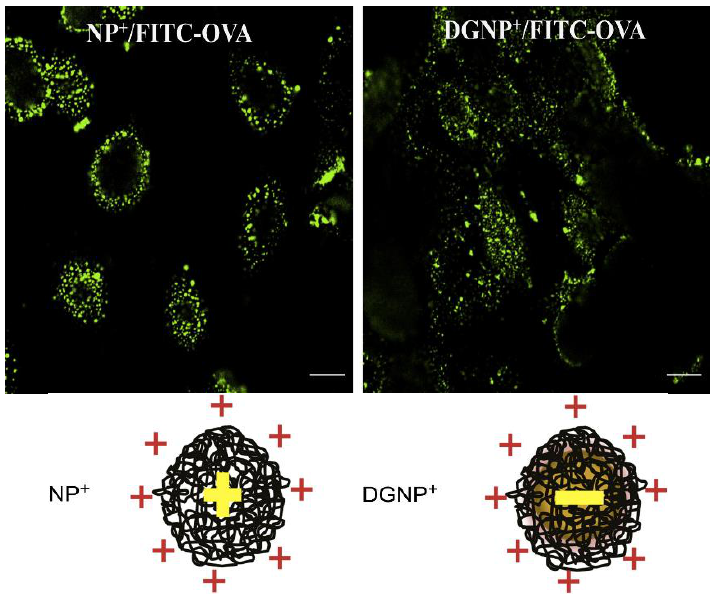
Figure 15. Comparison of ovalbumin (OVA) intracellular delivery by maltodextrin porous nanoparticles with outer and inner cationic charges (NP+) or outer cationic/inner anionic charges (DGNP+) using confocal microscopy to visualize OVA labeled with fluorescent markers (FITC-OVA). NP+ and DGNP+ were loaded with FITC–OVA and incubated for different periods with 16HBE cells. After 30 min incubation, cells were washed with PBS and fixed with 4% PAF. Intracellular FITC–OVA was visualized by confocal microscopy. Scale bar = 10 μm. Adapted from [244] with permission from Elsevier, Copyright 2012.